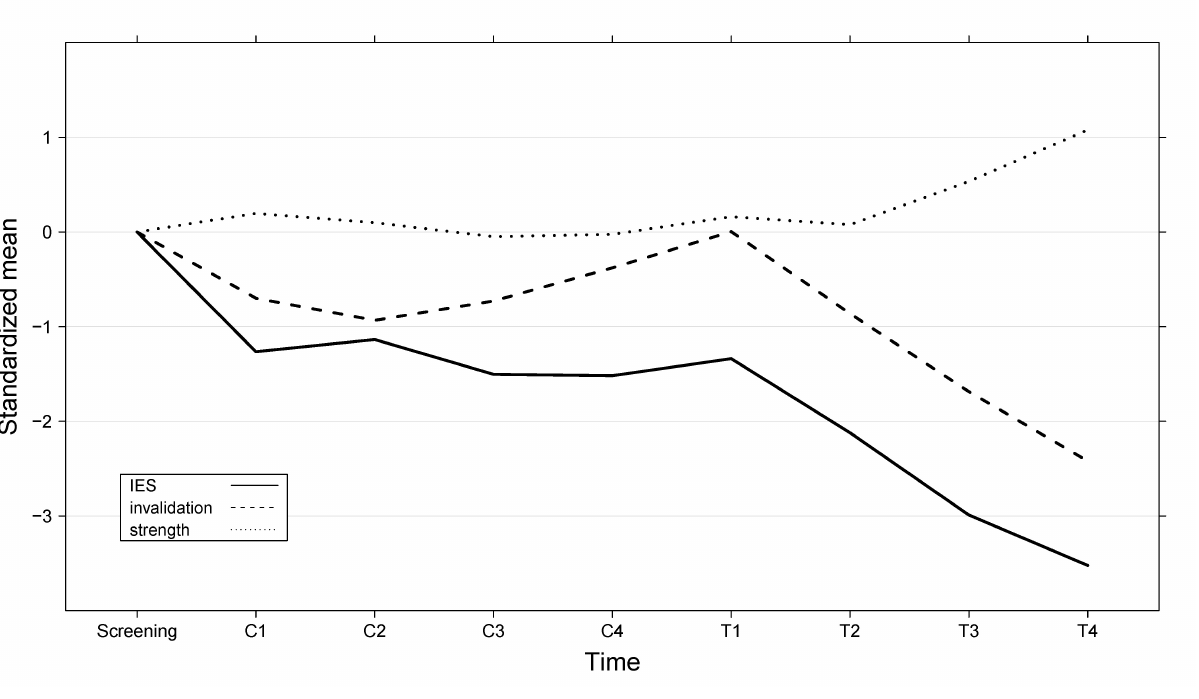
Figure 2. Standardized mean change in Impact of Event Scale (IES) scores and single-item assessments of Invalidation and Strength as measured weekly during the screening, the baseline control period (C1-C4), and the treatment period